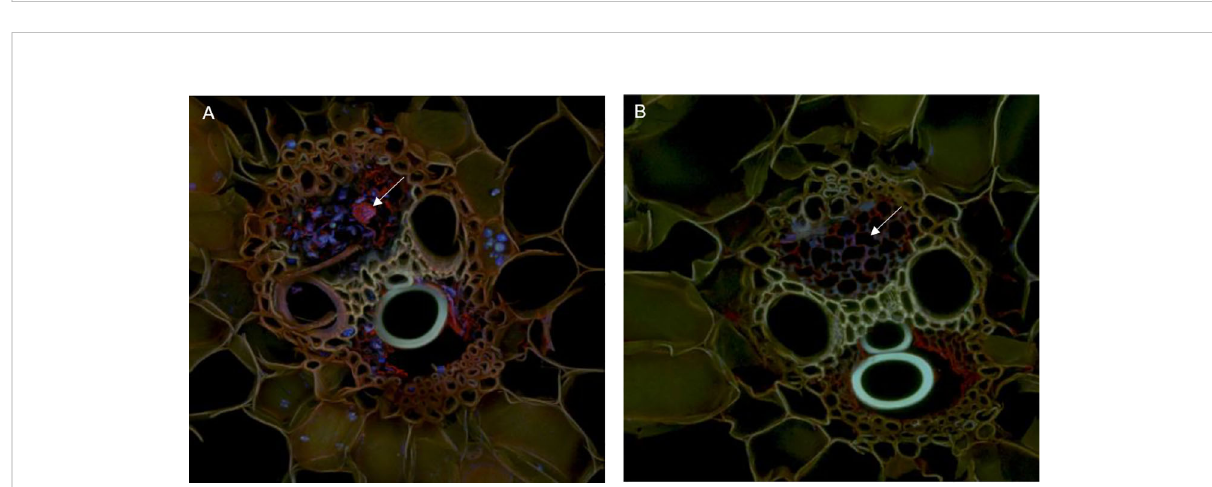
FIGURE 5 Vascular bundles of corn stem in culture with S. obliquus (A) or incubated with just BG-11 media (B) after fl uorescence staining with acridine orange. Arrows point to sieve elements. The blue and green fl uorescence in (A) is S. obliquus . In (A) , the acridine orange appears shifted to the red spectrum. Maximum-projection images by confocal